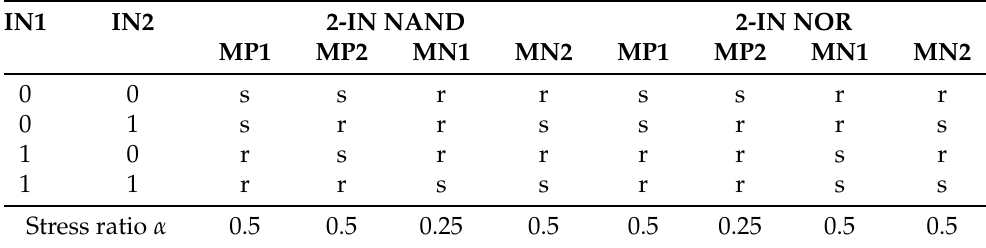
Table 1. Stress/recovery condition for 2-in NAND and NOR gates as a function of the input patterns. IN1 IN2 2-IN NAND 2-IN NOR MP1 MP2 MN1 MN2 MP1 MP2 MN1 MN2 0 0 s s r r s s r r 0 r s r r r r s r 1 1 r r s s r r s s Stress ratio α 0.5 0.5 0.25 0.5